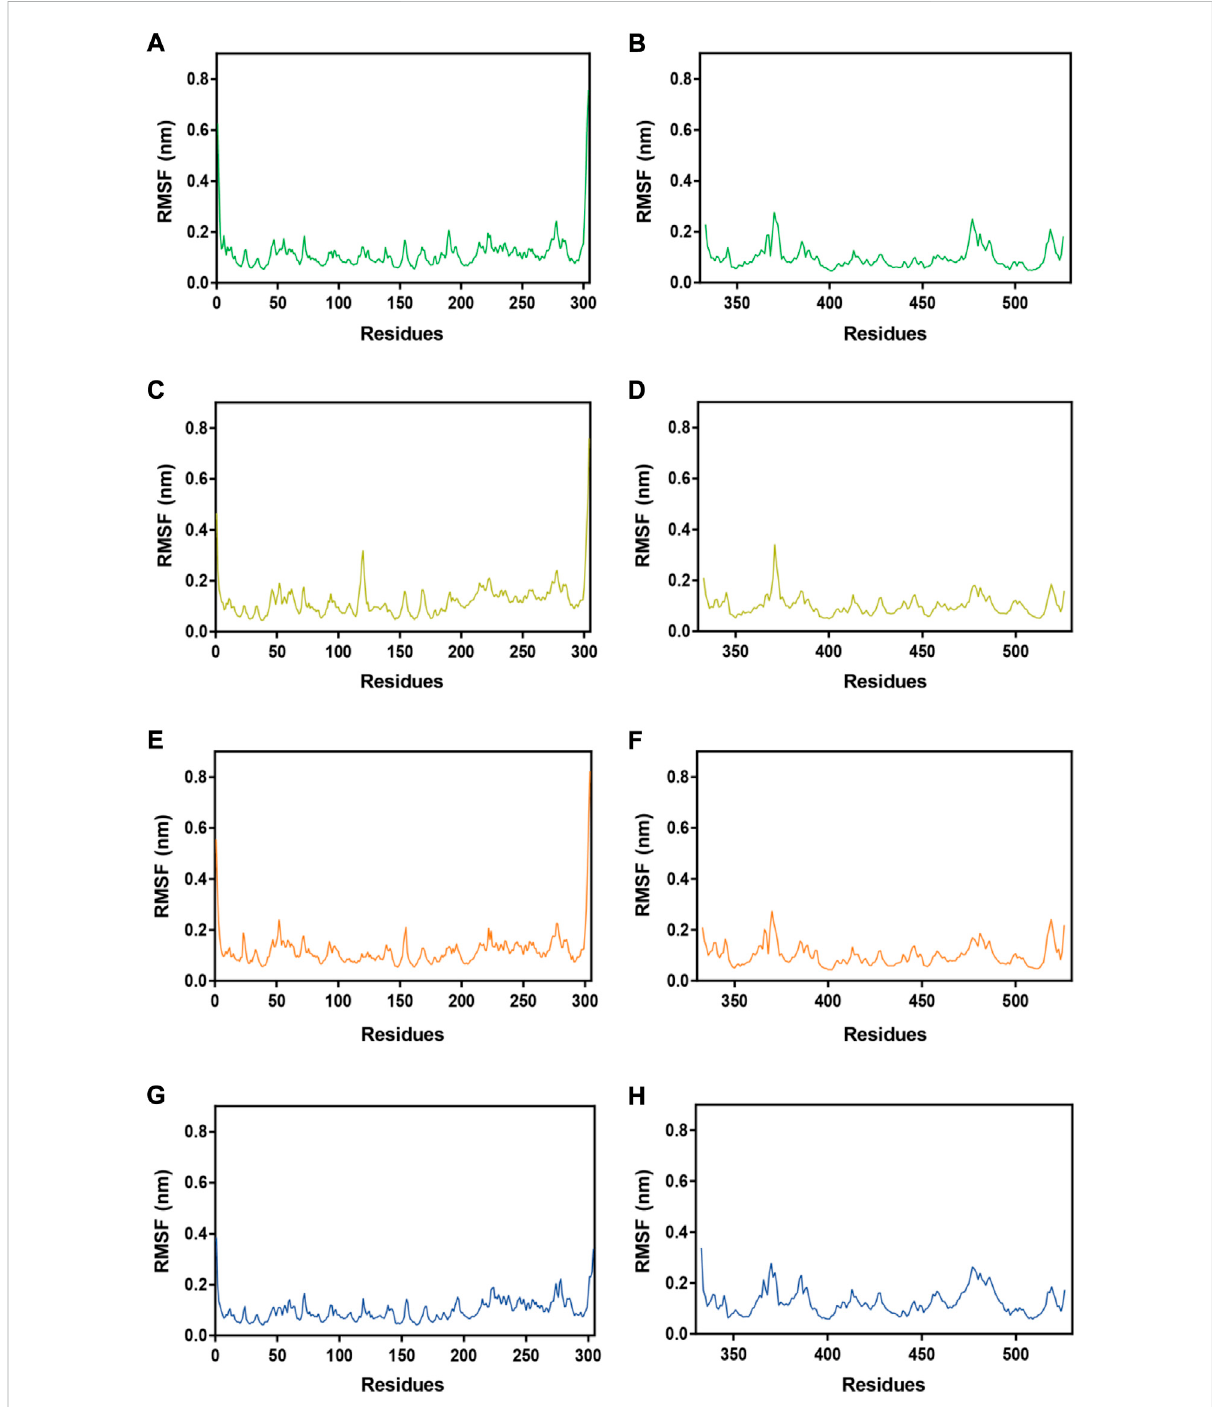
FIGURE 6 RMSFs ofC α atomsduring MD-simulation. (A , B) MR-1incomplexwithMpro andRBD,respectively; (C , D) MR-2incomplexwith MproandRBD, respectively; (E , F) MR-3 in complex with Mpro and RBD, respectively; (G , H) MR-4 in complex with Mpro and RBD,